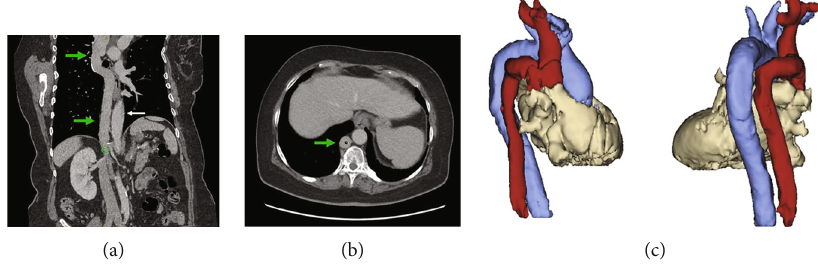
Figure 4: (a) Stretched reconstruction of a venous CT with azygos continuation (green arrows), aorta (white arrow), and diaphragmatic passage of the azygos (green circle). (b) Axial CT view, venous phase, showing a prominent azygos vein (green arrow). (c) 3D reconstruction showing the azygos continuation/superior vena cava (red) and the aortic arch (blue) in a right lateral and posterior view.